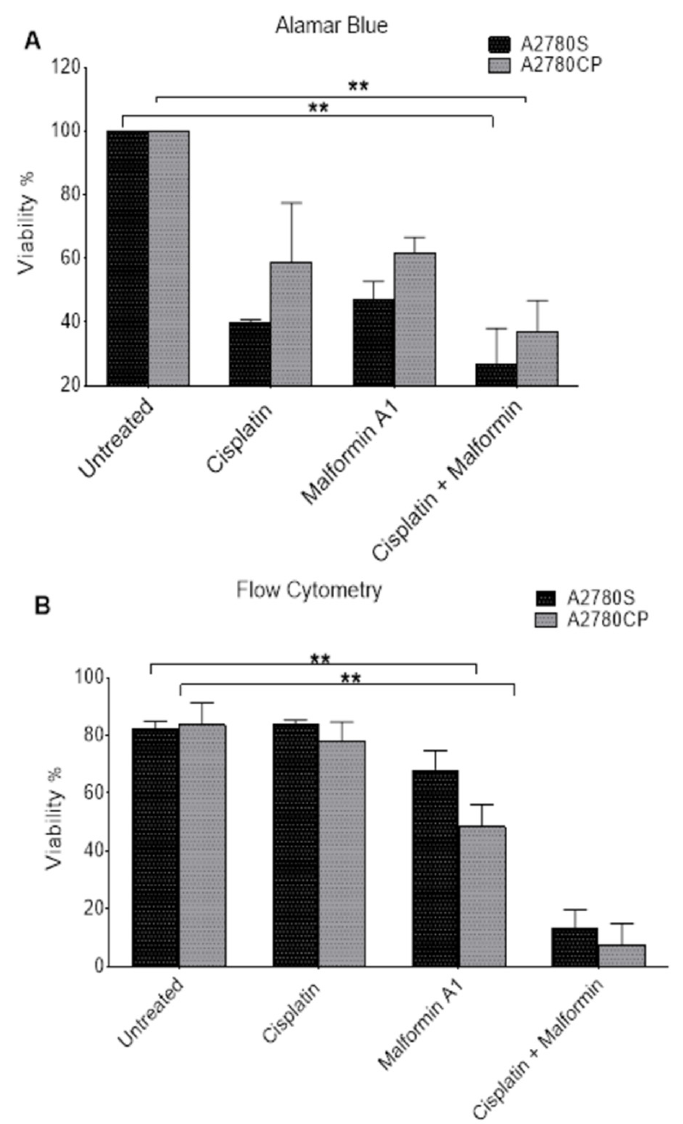
Figure 3 . Cell survival assessment following treatment. The effect of combining cisplatin and MA1 on cisplatin-sensitive and cisplatin-resistant cells using Alamar Blue ( A ) and flow cytometry ( B ). The cells were treated with IC50 of cisplatin and Malformin A1 for 24 h. ** p < 0.01.